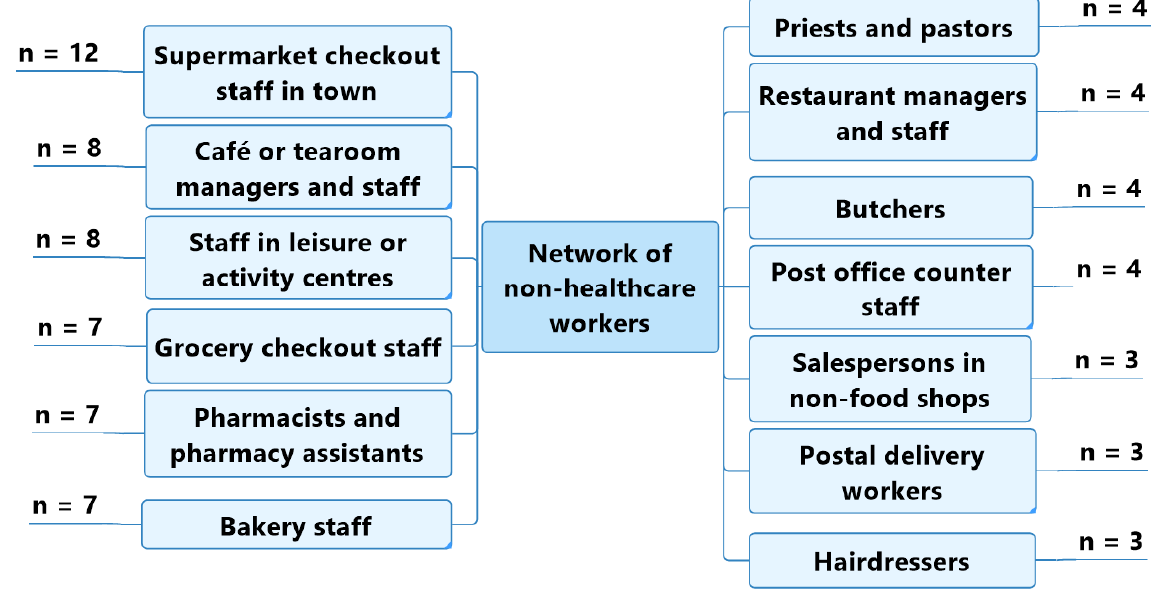
Figure 3. Professional characteristics of the non-healthcare workers regularly met by participants without self-reported cognitive impairment.